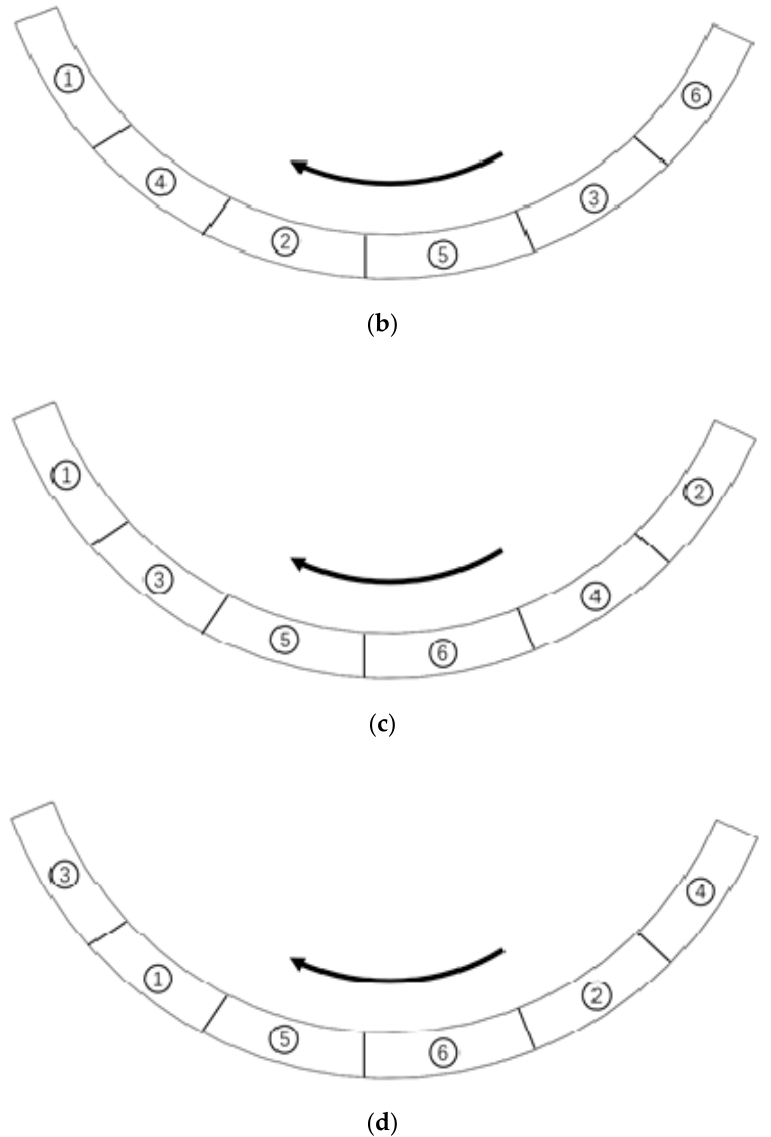
Figure 7. Schematic diagram of welding scheme: ( a ) scheme 1; ( b ) scheme 2; ( c ) scheme 3; ( d ) scheme 4.